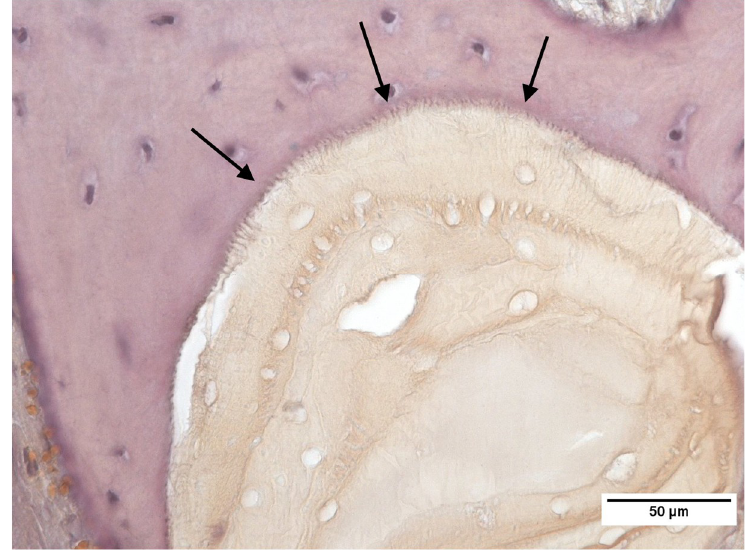
Figure 1. Xenogeneic bone graft (Cerabone ® ) showing seamless tissue integration. Arrows are used to highlight the bone graft/host bone tissue interface.